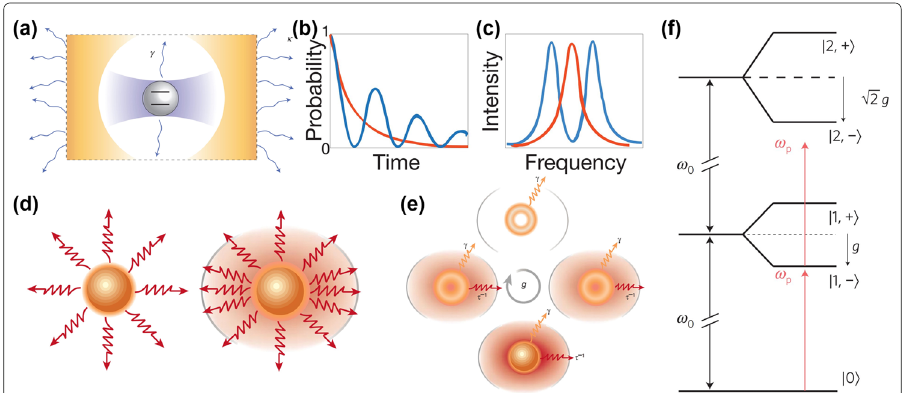
Fig. 1 Schematic diagram of CQED systems. a A typical CQED system consisting of a single quantum emitter (here is two level) and a cavity with coupling coefficient g , cavity loss κ , and spontaneous emission rate γ [7]. b The probability of excited-state with time evolution and c transmission spectrum for weak (red curve) and strong (blue curve) coupling regimes [5]. d Schematic diagram of Purcell enhancement at weak coupling regime [3]. e Vacuum Rabi oscillation with period energy exchange at strong coupling regime [3]. f Schematic of Rabi splitting energy by dressed state theory [7]